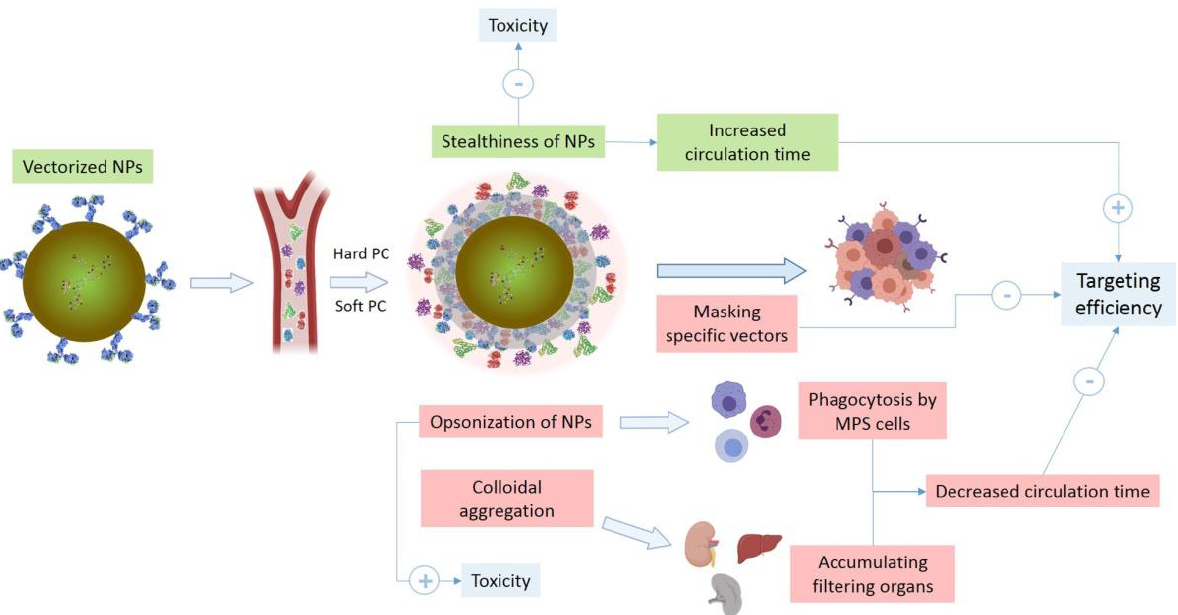
Figure 3. Possible effects on nanoparticle stability, safety and pharmacokinetics due to protein corona formation and interaction after systemic administration.